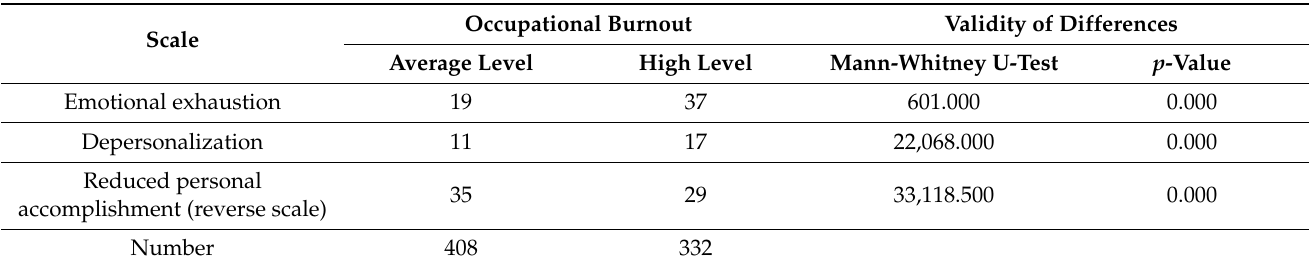
Table 3. Levels of occupational burnout among ICU HCWs (K-Means Clustering).